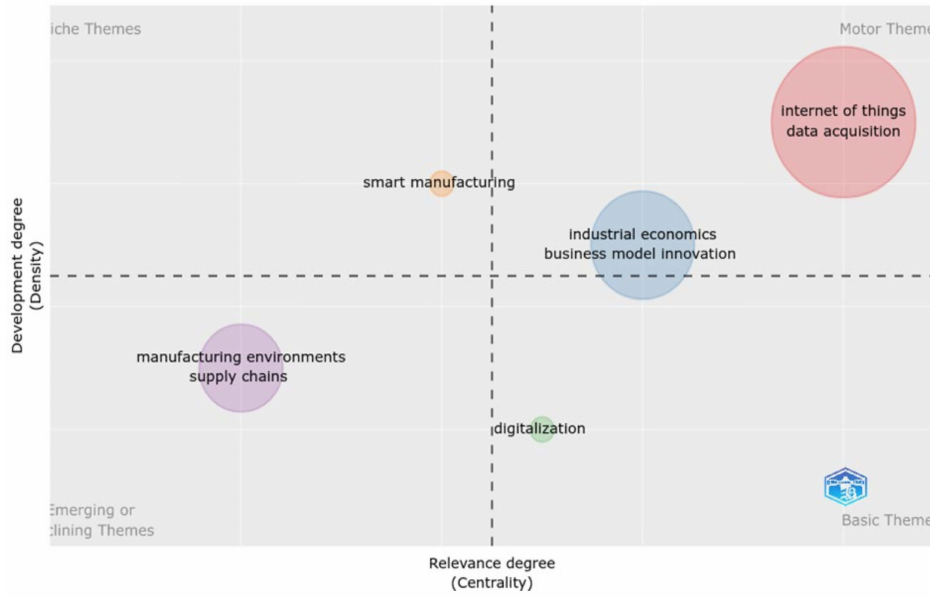
Figure 5. Pre-pandemic Thematic